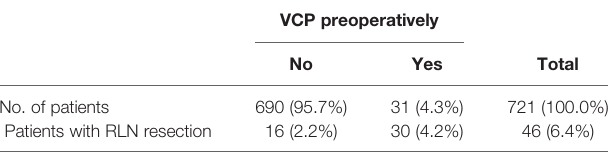
TABLE 1 | Number (%) of patients who required resection of the recurrent laryngeal nerve in A.M. ’ s personal series from 1998 to 2008 consisting of primary thyroid cancer